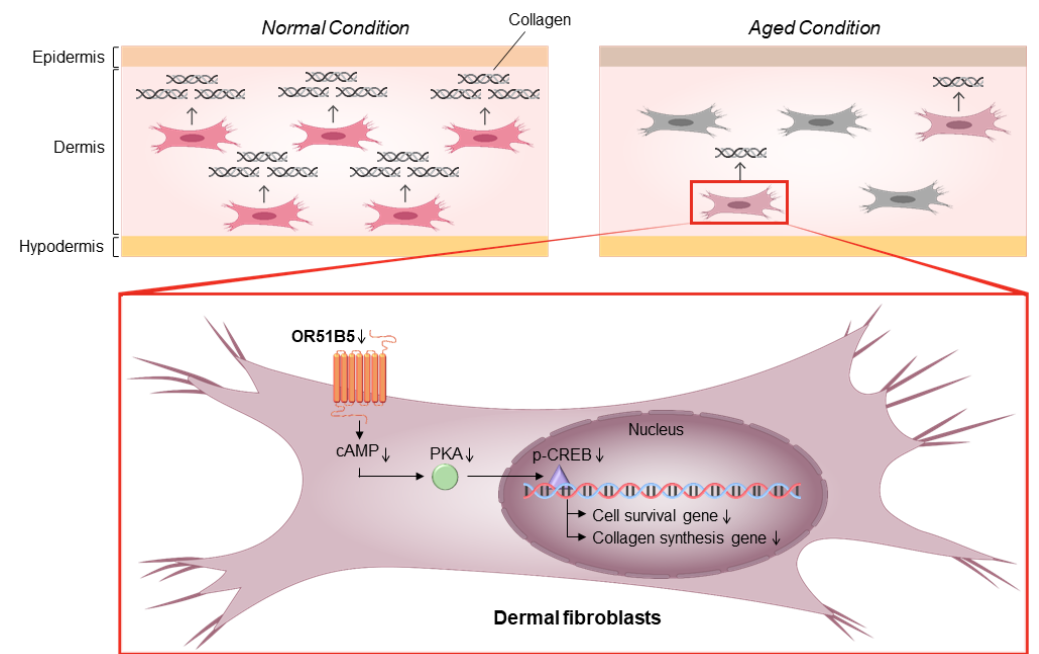
Figure 9. A proposed mechanism of OR51B5-mediated cell survival and collagen synthesis in Hs68 cells. Cell survival and collagen synthesis can be regulated through OR51B5-induced cAMP and the downstream PKA pathway. Then, PKA phosphorylates CREB protein, affecting cell survival- and collagen synthesis-related gene transcription. The thin downward arrows depict the downregulation of molecules related to the survival and collagen synthesis in OR51B5-knockdown cells. The bold arrows linking the molecules depict the signal transduction of these molecules.